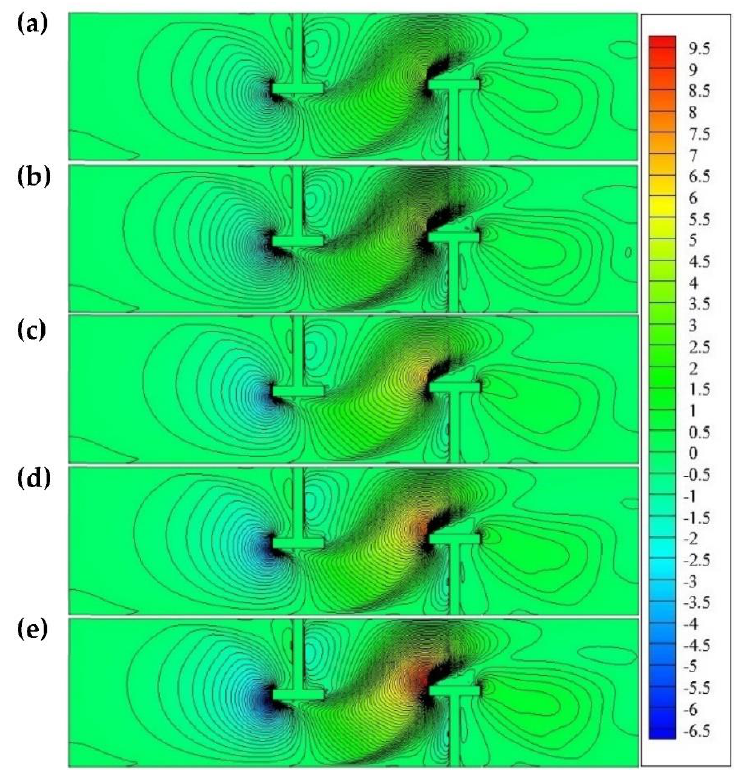
Figure 6. Fields of Y-velocity for: Re = ( a ) 12,000; ( b ) 17,000; ( c ) 22,000; ( d ) 27,000; ( e ) 32,000.